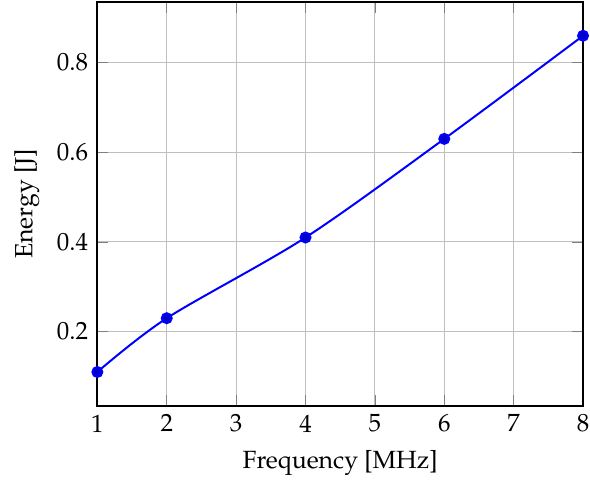
Figure 8. Effect of Reducing Frequency on Consumption.